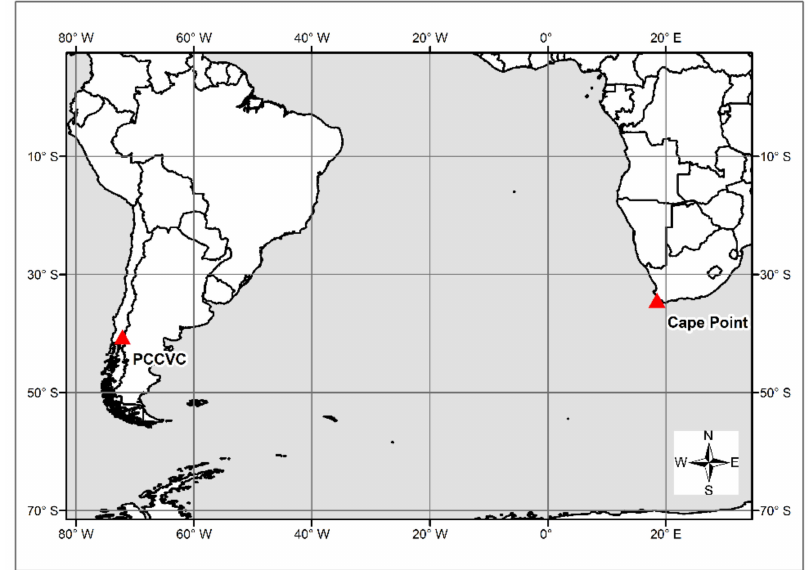
Figure 1. Map showing the location of the eruption site, Puyehue-Cord ó n Caulle volcanic complex in South America and the secondary site, Cape Point in South Africa